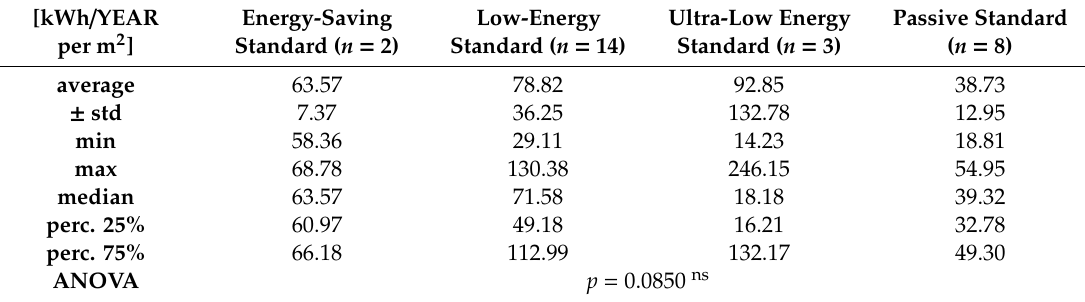
Table 6. Annual energy demand for heating categorized according to energy standards calculated per m 2 of useful floor area of the analyzed column wood constructions.